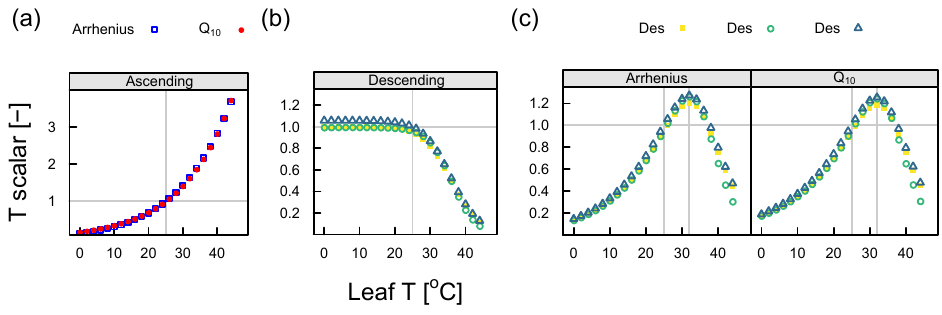
Figure 6. Biochemical rate scalars for instantaneous temperature responses for (a) the ascending component of the response, (b) the de- scending component of the response, and (c) the combined response. Arrhenius shown as blue squares (a) and in panel (c) . Q 10 shown as red circles (a) and in panel (c) . Descending components (b, c) from Collatz et al. (1991) are shown as yellow squares, Cox et al. (1998) as green circles, and the modified Arrhenius relationship as blue